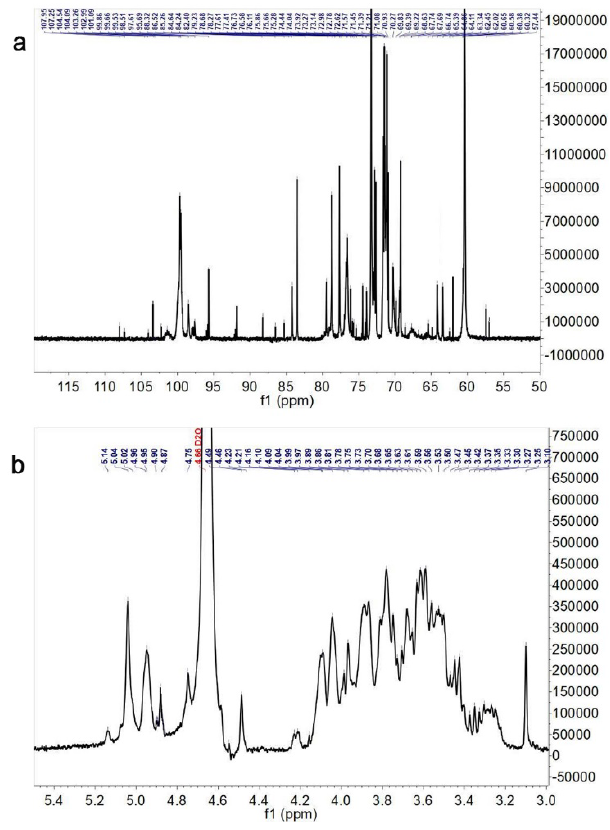
Figure 3. 13 C (a) and 1 H (b) NMR spectrum of Pan. Figure 3. 13 C ( a ) and 1 H ( b ) NMR spectrum of